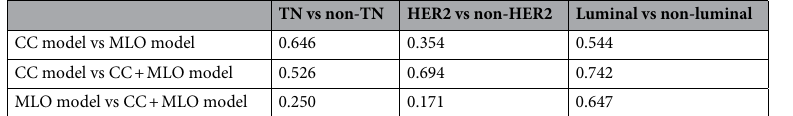
Table 3. Comparison of AUC (area under the receiver operating characteristic curve) values between the radiomics models (P value) with Delong’s